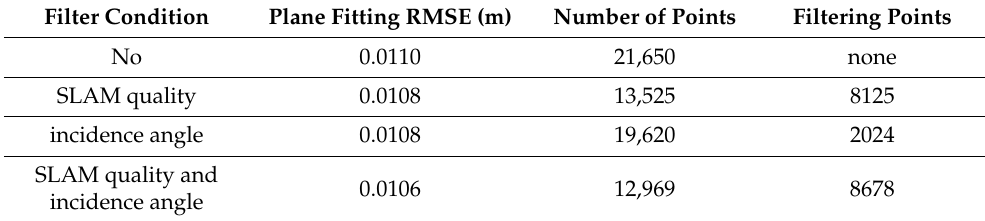
Figure 11. Planar point cloud location and point cloud data used for point cloud filtering analysis from dataset DATA1. Table 5. Analysis results of filtering conditions using a planar point cloud in dataset DATA1.